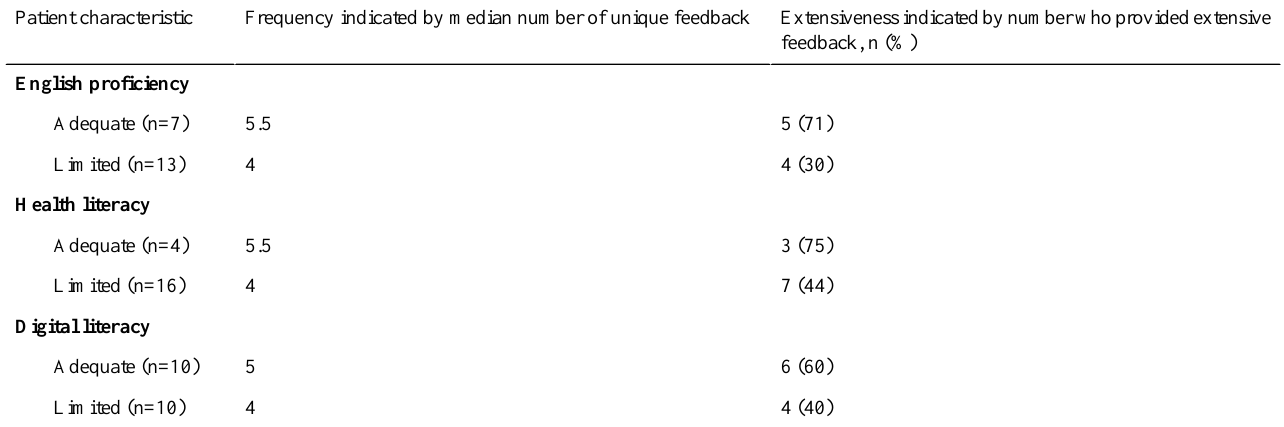
Extensiveness indicated by number who provided extensive feedback, n